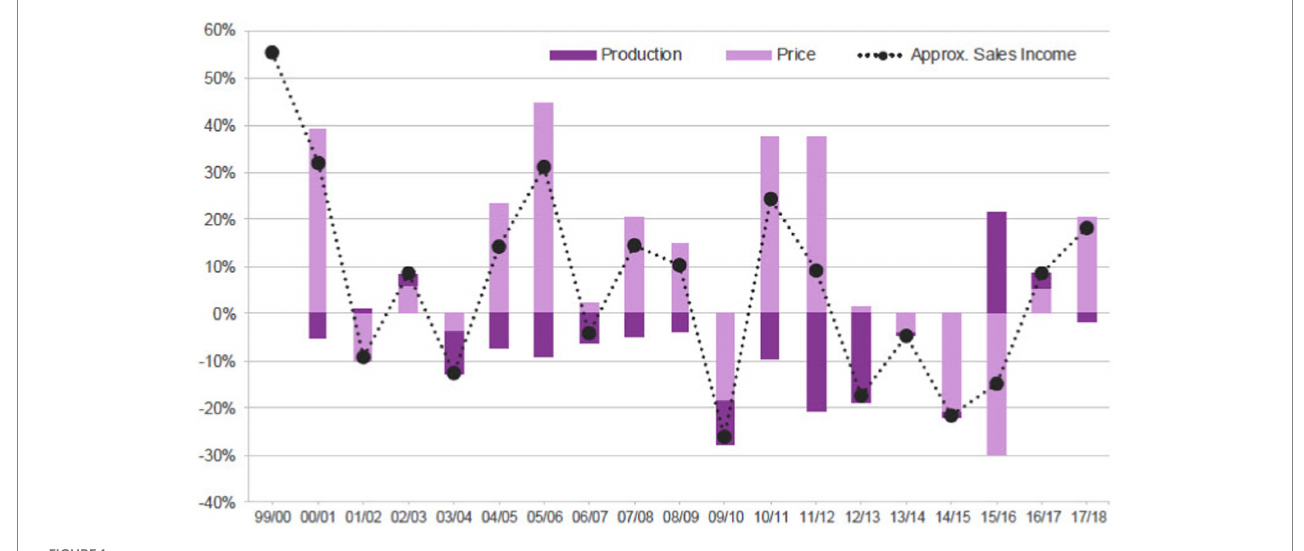
FIGURE 1 Changes in price, volume and approximate sales income (Scottish Government, 2018: